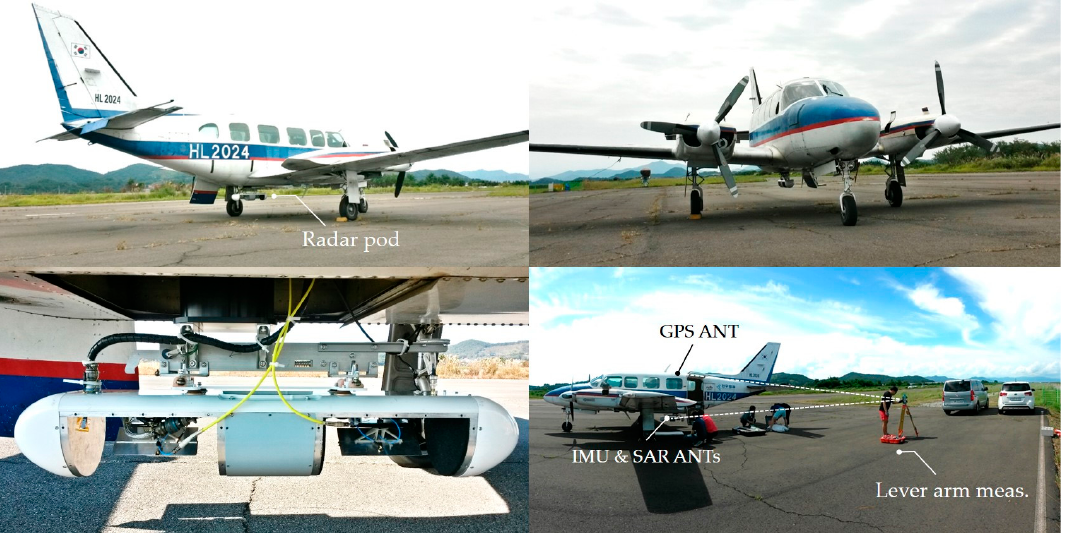
Figure 8. Overview of the airborne FMCW SAR system: radar pod was mounted at the bottom of the fuselage of PIPER PA31-350 and Tx/Rx antennas of NanoSAR-B were installed for left-looking as a default setup. The lever arm was measured with a total station, then its spatial coordinate was entered into NanoSAR-B as a system parameter and used for SAR image focusing.